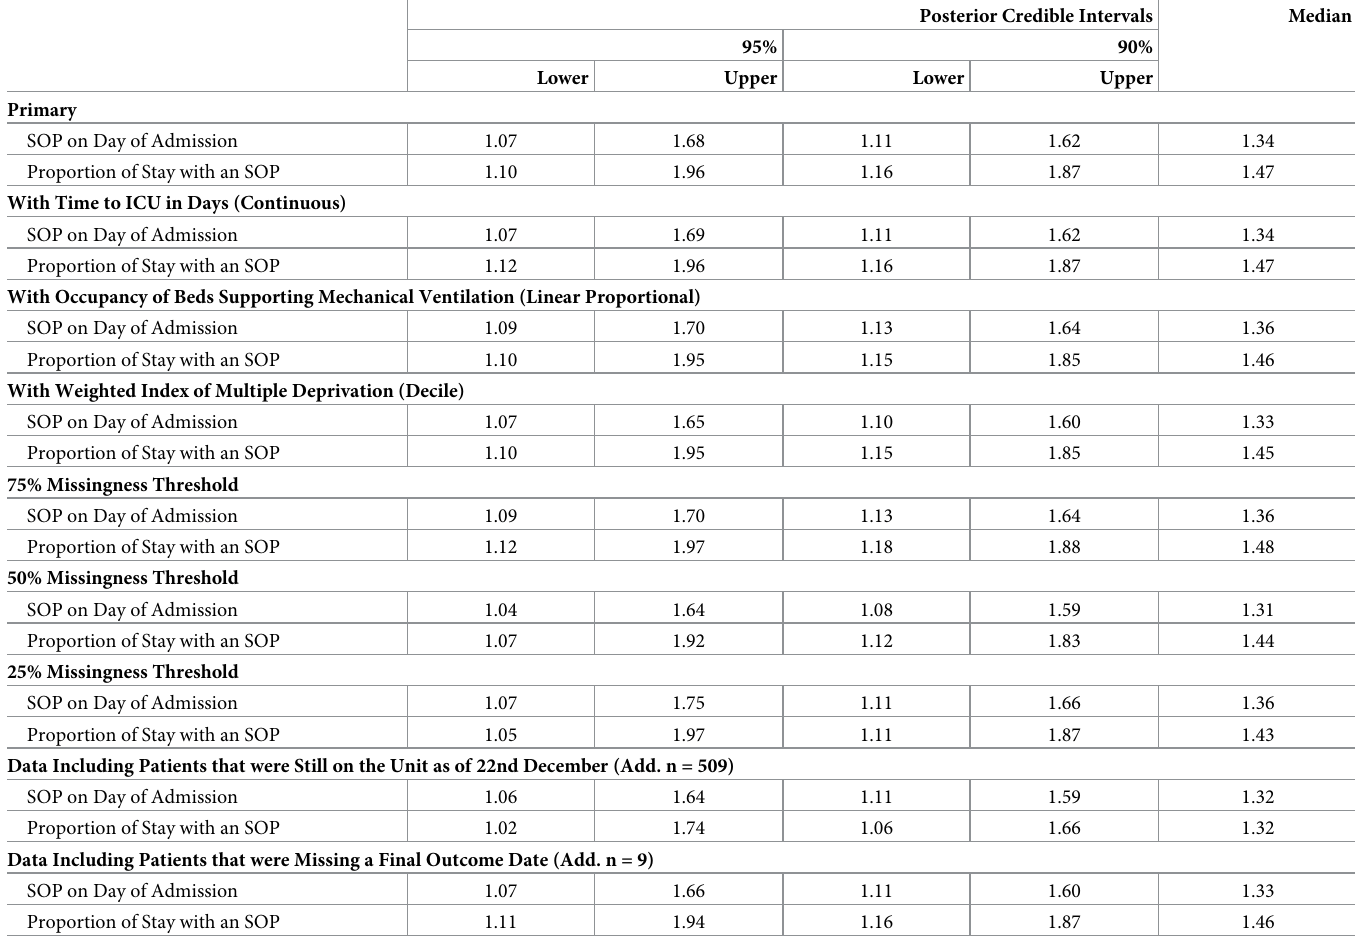
Table 3. Marginal posterior densities for the primary effects of interest, under the various sensitivity analyses that were carried